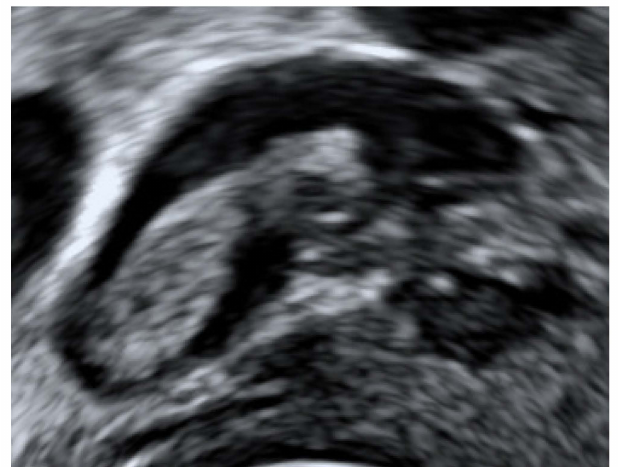
Figure 1. Transvaginal B-mode image of uterine vein